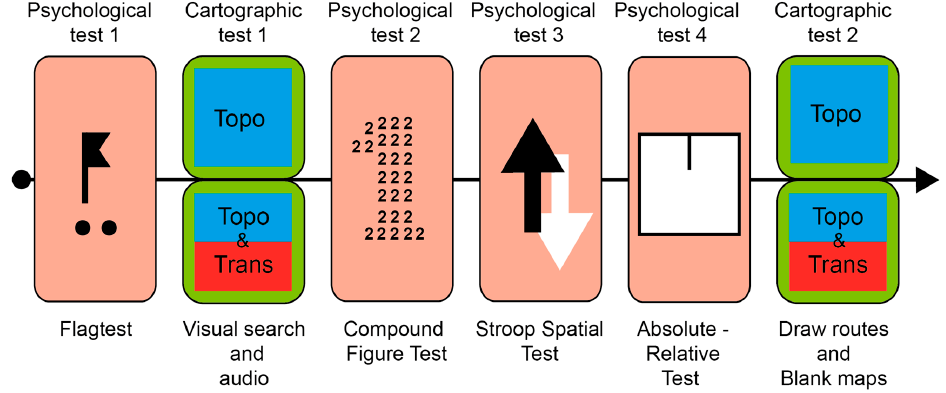
Figure 11. Scheme of the whole experimental design (adapted from Kuka ň ová [84]).